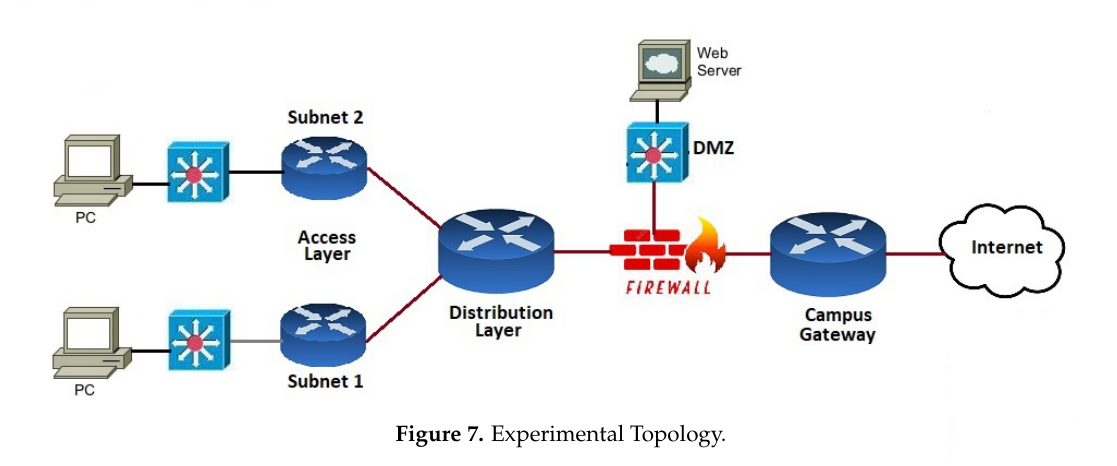
Figure 7. Experimental